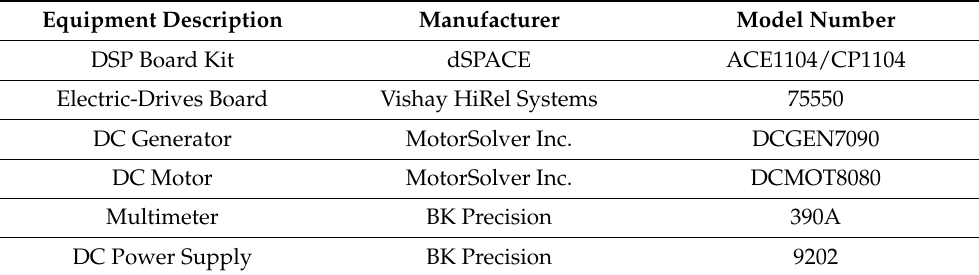
Figure 5. Block diagram of an HIL framework (top) and experimental setup (bottom). Table 1. The equipment used in the experimental